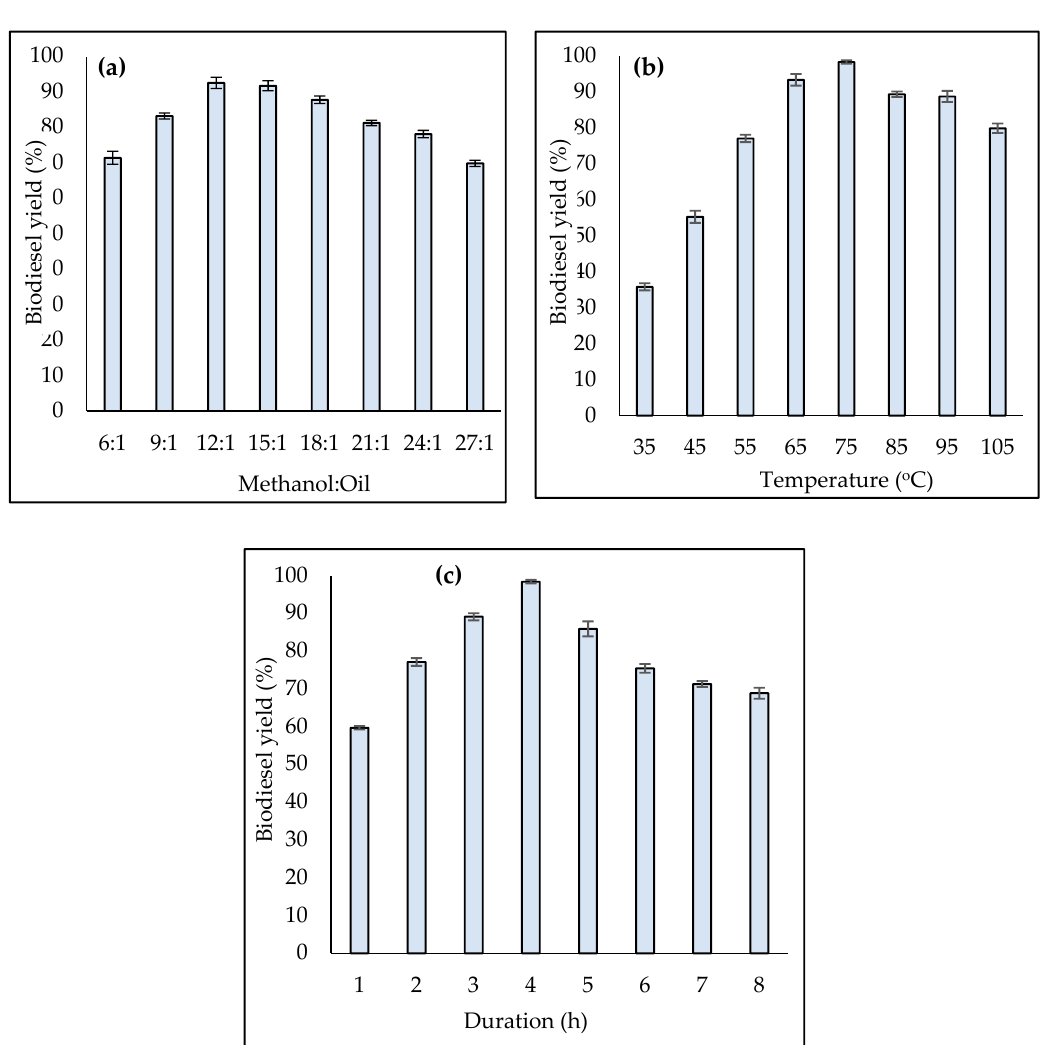
Figure 7. ( a ) E ff ect of methanol to oil molar ratio on the biodiesel yield using RHC / K 2 O-20% / Fe-5% catalyst ( b ) E ff ect of temperature on the biodiesel yield using RHC / K 2 O-20% / Fe-5% ( c ) E ff ect of reaction time on the biodiesel yield using RHC / K 2 O-20% / Figure 7. ( a ) Effect of methanol to oil molar ratio on the biodiesel yield using RHC/K 2 O-20%/Fe-5% catalyst ( b ) Effect of temperature on the biodiesel yield using RHC/K 2 O-20%/Fe-5% ( c ) Effect of reaction time on the biodiesel yield using RHC/K 2 O-20%/Fe-5%.